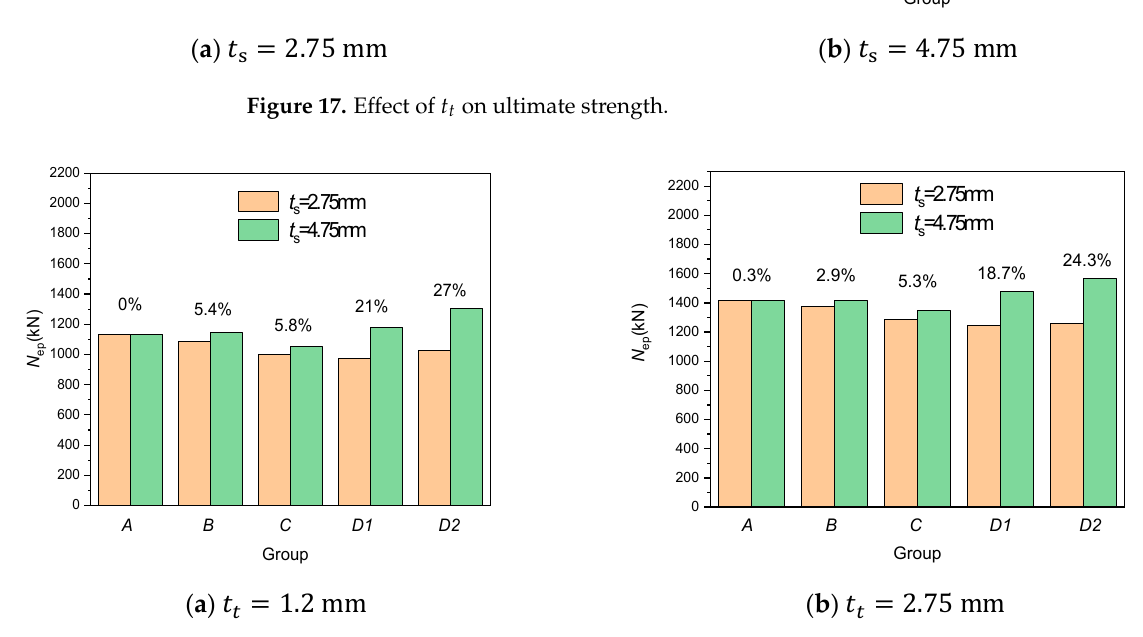
Figure 18. Effect of 𝑡 (cid:3046) on ultimate strength.